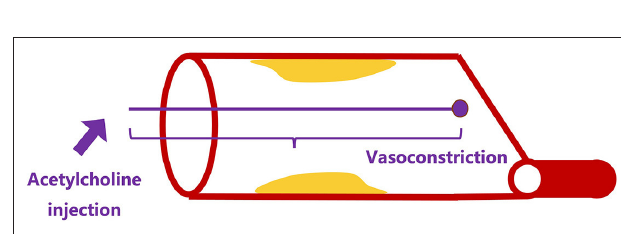
FIGURE 5 | Illustration of coronary reactivity